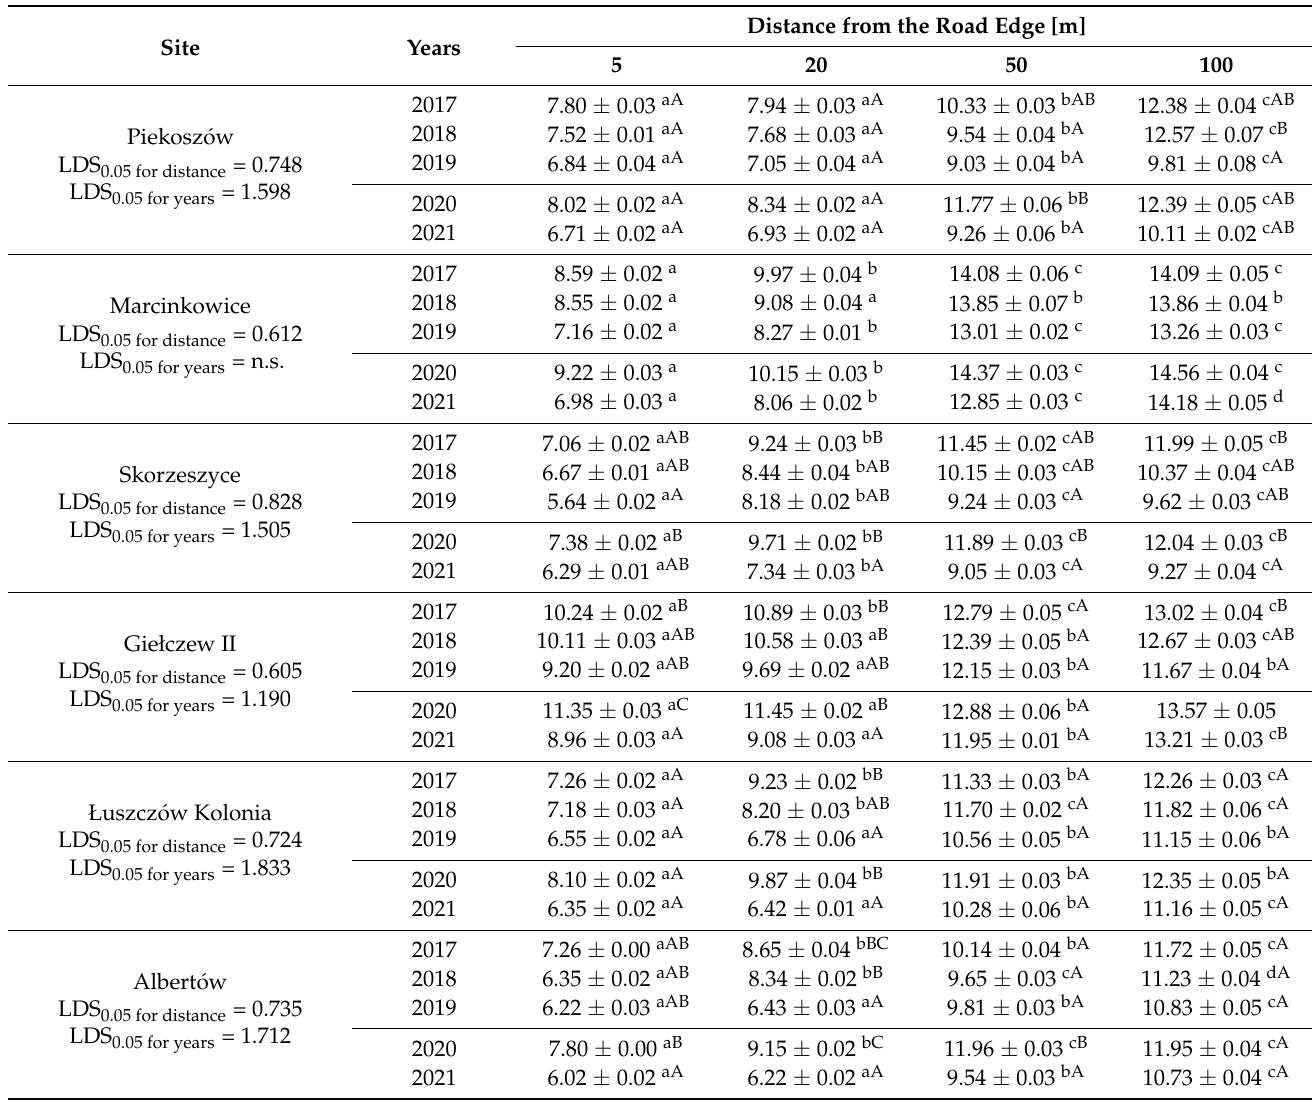
Table 10. Neutral phosphatase activity (APh in mmol PNP kg − 1 h − 1 ) in soils before the COVID-19